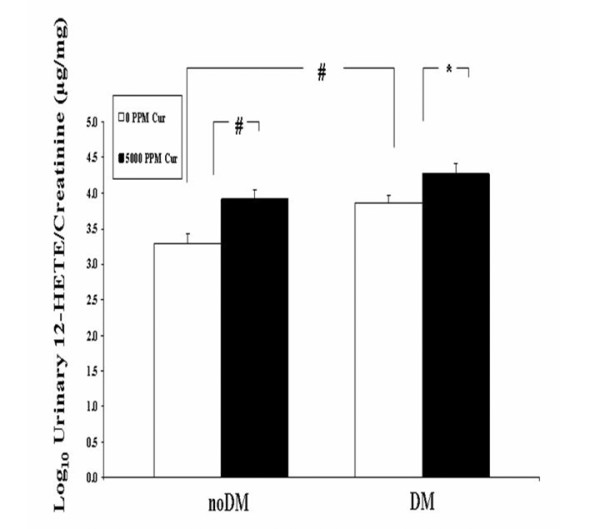
Curcumin did not lower U 12-HETE/cr excretion in noDM and DM mice. Urinary 12-HETE/cr ratios for noDM and DM mice fed chow with 0 and 5,000 ppm curcumin. Mice were fed curcumin post-Stz injections (Experiment 1). Graph represents pooled data (day 9 and 15). *P < 0.05; #P < 0.01.